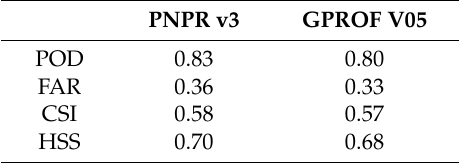
Table 11. Same as Table 9 but for the GMI overpass at 16:35 UTC on 9 August